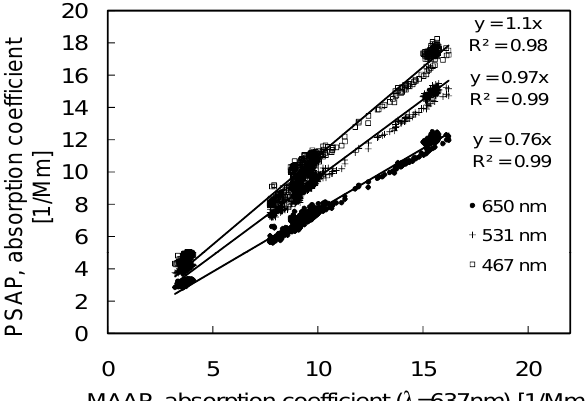
Fig. 8. Ambient air runs during GAW2005. Aethalometer (model AE31, 660nm) absorption coefficient vs. MAAP absorption coeffi- cient ( λ =637nm). Aethalometer data were corrected using Wein- gartner et al.